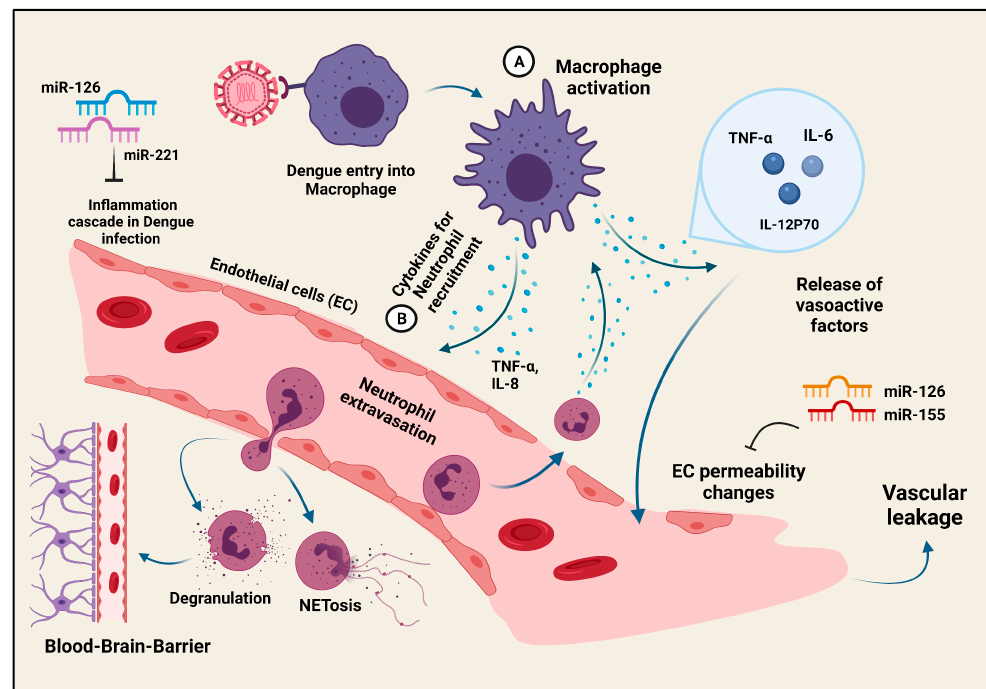
Figure 3. Inflammatory responses during Dengue virus infection: Dengue virus entry into the target macrophage cell triggers the inflammatory cascade. A. Macrophage activation leads to the increase in the vasoactive factors to induce permeability changes in the EC membrane ultimately leading to vascular leakage. B. Neutrophils, the major effectors in the inflammation process, are recruited by cytokines released from macrophages to migrate to the nearby tissues. Neutrophils under Dengue attack are capable of exhibiting NETosis, a phenomenon marked by the release of traps or NETs to capture the Dengue virus. Apart from NETosis, the neutrophils degranulate, an event that contributes to the penetration of the blood-brain-barrier to cause neuroinflammation. Certain miRNAs, miR-126, miR-155, and miR-221, which are potential rescuers of the EC permeability changes and inflammation, respectively, are being considered as therapeutic targets in order to reduce the damaging effects of inflammation in the Dengue patients.